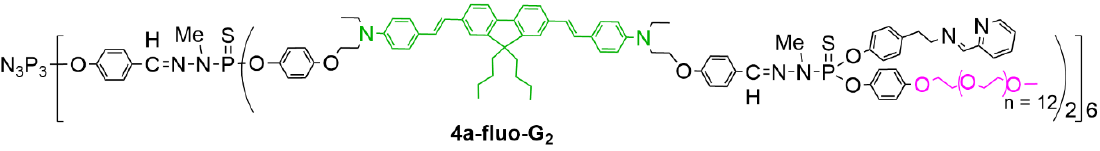
Figure 6. Brightly fluorescent dendrimer, synthesized for investigating the behaviour of the pyridine imine dendrimers in cells.